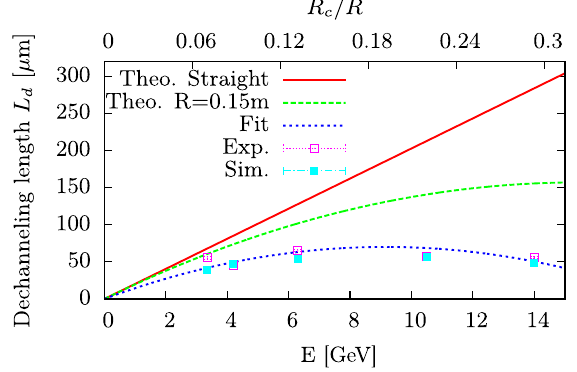
FIG. 19. A plot of the “ simple ” dechanneling formulas of ffiffiffiffi p E (Fit 2). Eqs. (7), (9), (23) and of the experimental and simulated